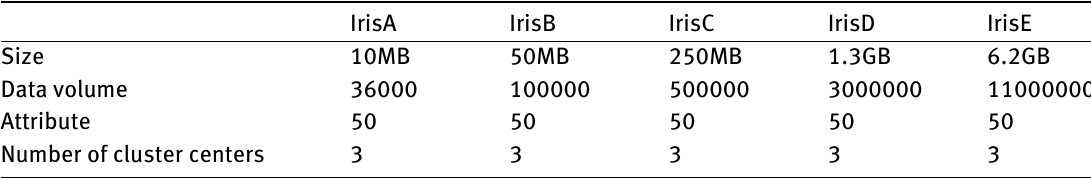
Table 1: Experimental data set